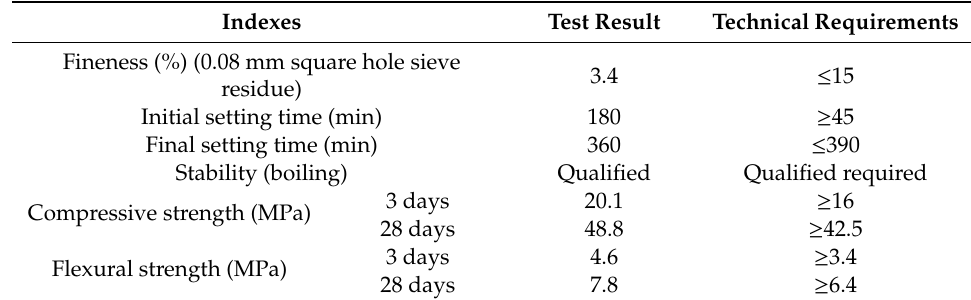
Table 2. Technical properties of P.O. 32.5 cement.